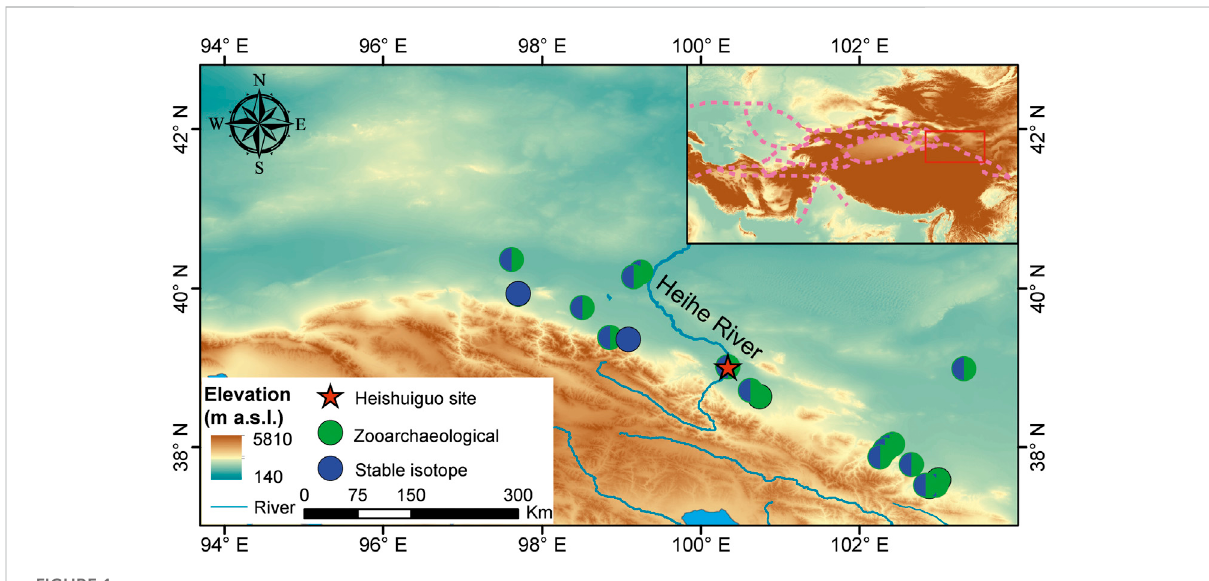
FIGURE 1 Location of sites in the study area referred to in this